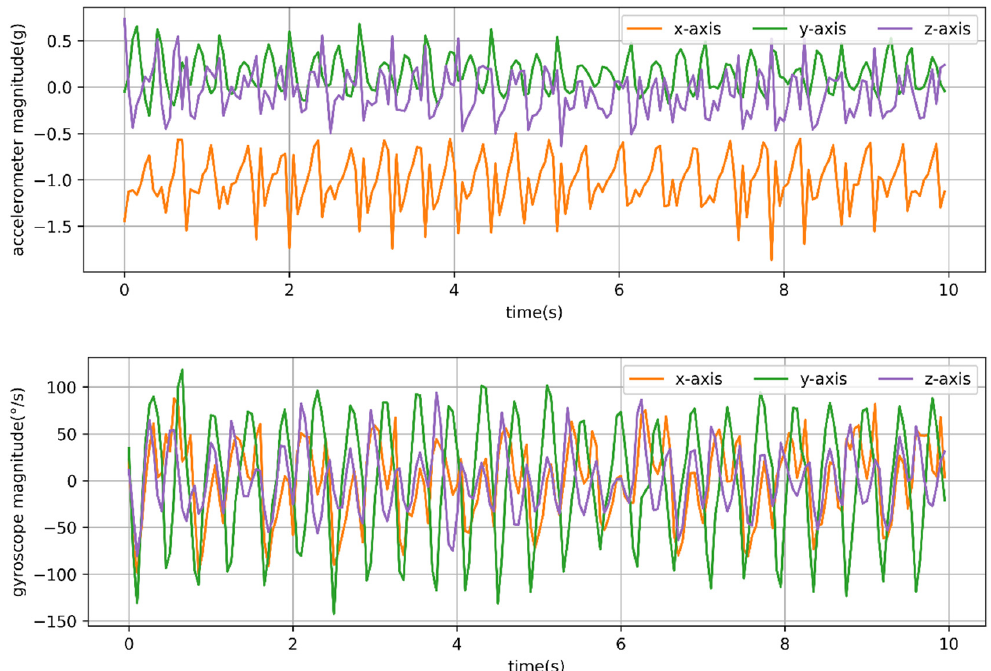
Figure 3. Time series of three-axis accelerometer and three-axis gyroscope signals from a 20 Hz sampling rate for observed behavior of 10 s walking. Acceleration is in g (9.8 m/s 2 ) units.